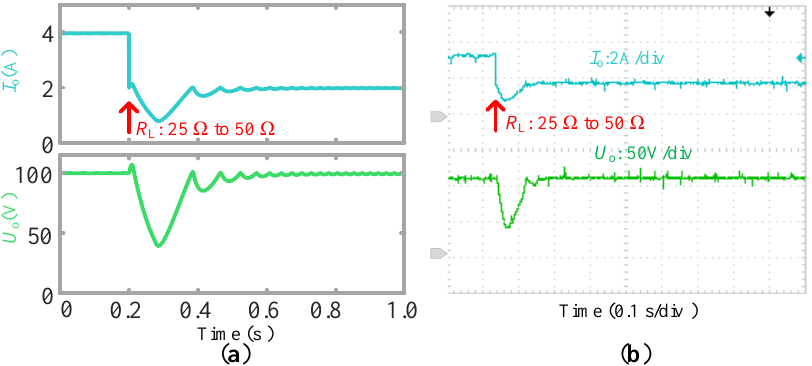
Figure 17. Simulated and experimental CV power transfer results of APC system: ( a ) simulated; and ( b ) experimental. I o , output current (blue lines); U o , output voltage (green lines).